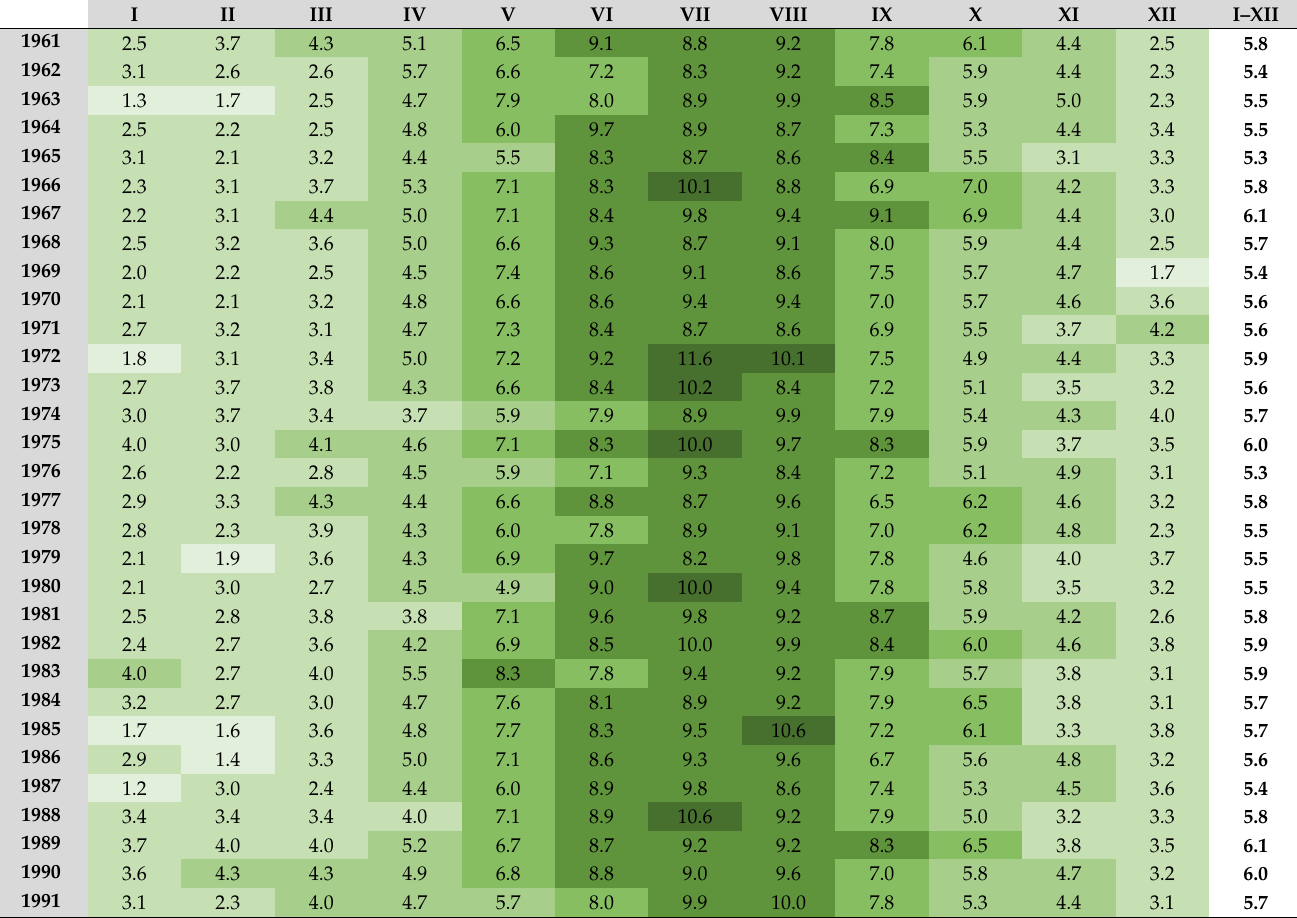
Table 3. Monthly average moisture content from 1961 to 2020 in